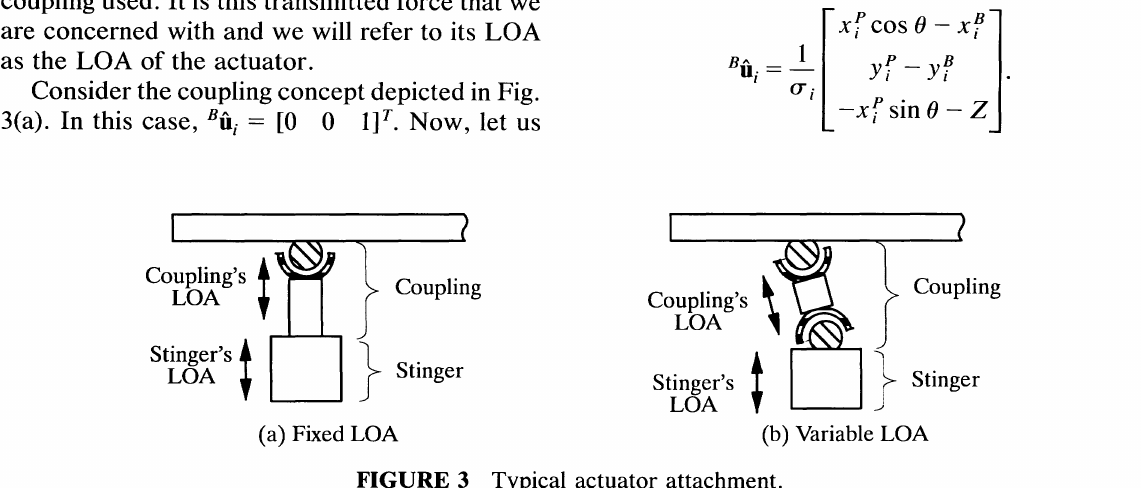
FIGURE 3 Typical actuator